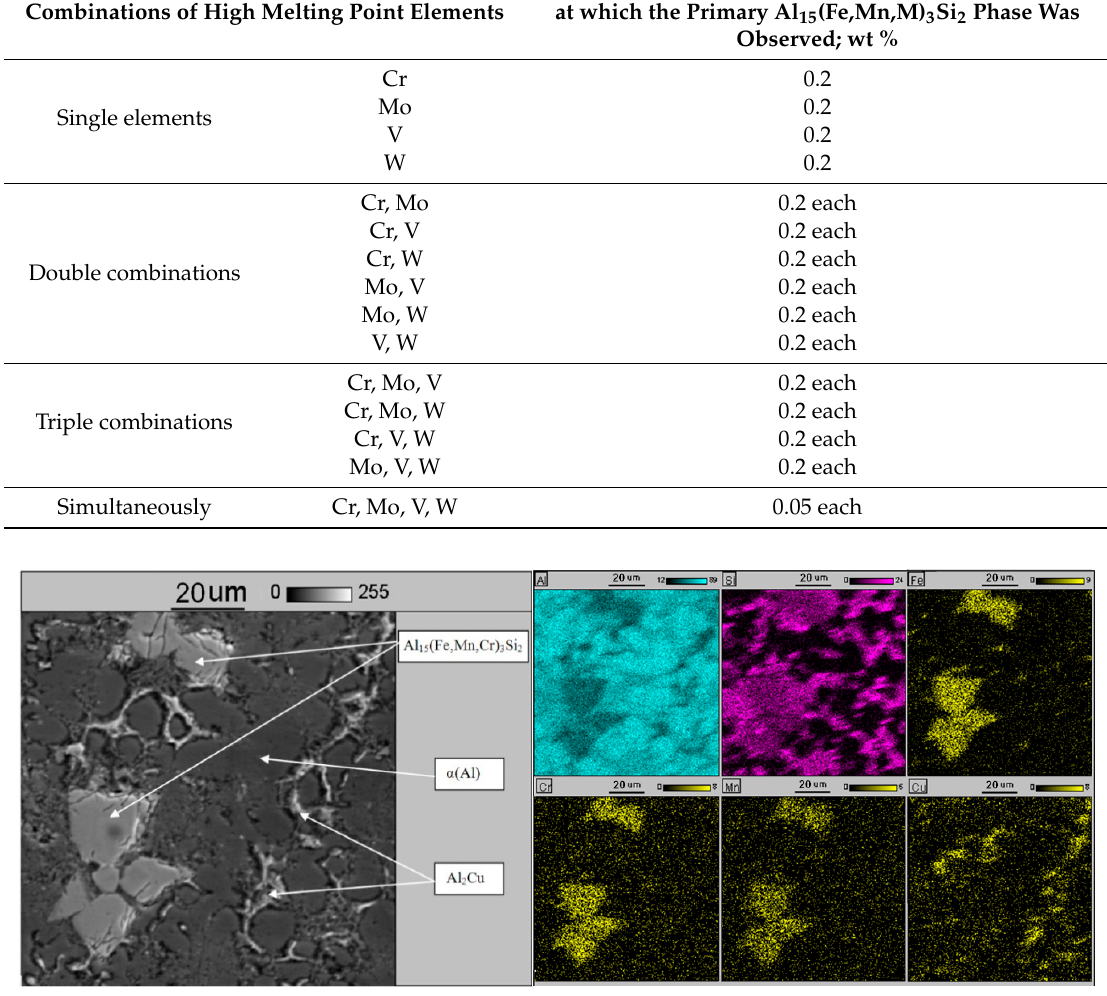
Figure 14. An example of the region in the microstructure of Al-Si alloy containing 0.5 wt % Cr with a ‘new’ phase and the map of Si, Fe, Cr, Mn, and Cu distribution.